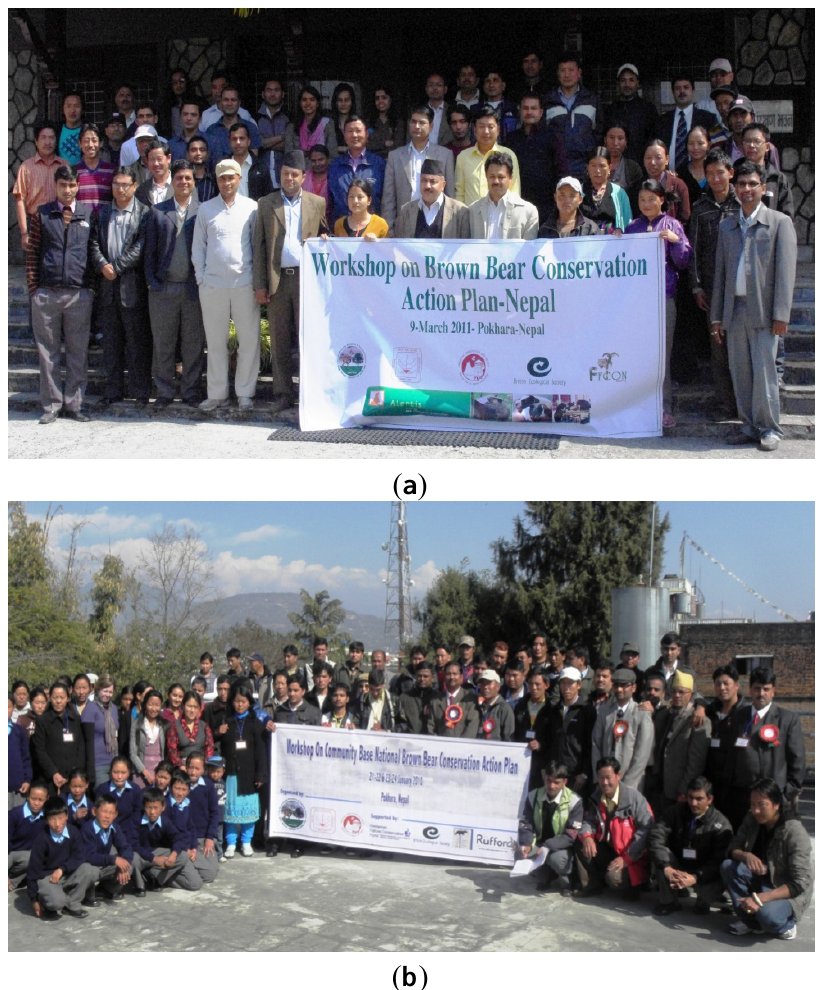
Figure 5. Conservation Action Plan Workshop (Pokhara, Nepal) participants. ( a ) 9 March 2011 workshop; ( b ) 21–24 January